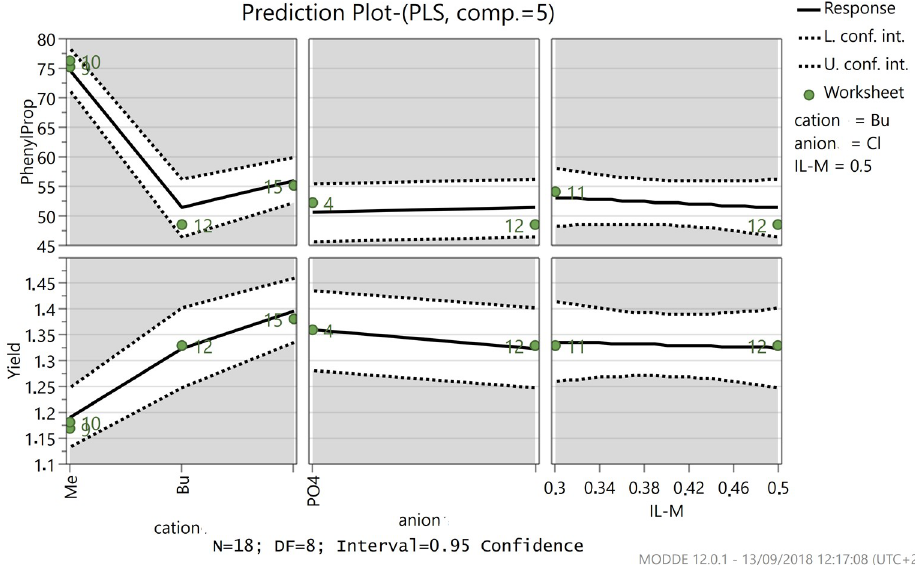
Figure 5. Prediction plot obtained by MODDE optimizer.